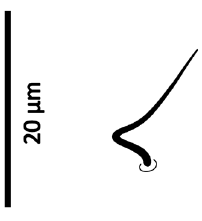
Plate 2. Zygoseius lindquisti sp. n., female, A, B spermathecal apparatus in two different females (Abbre- viations as mentioned in Plate 1).